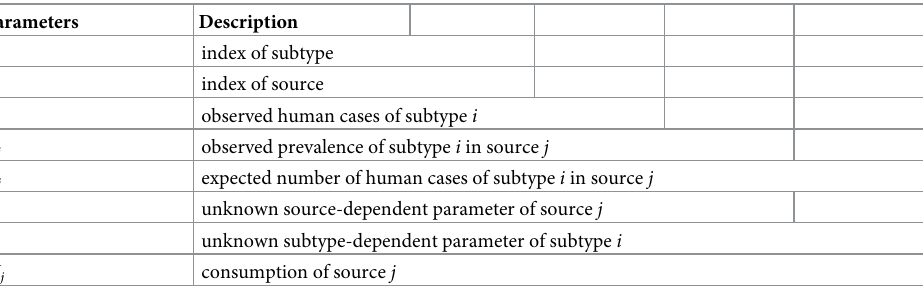
Table 2. Parameters used in the model.